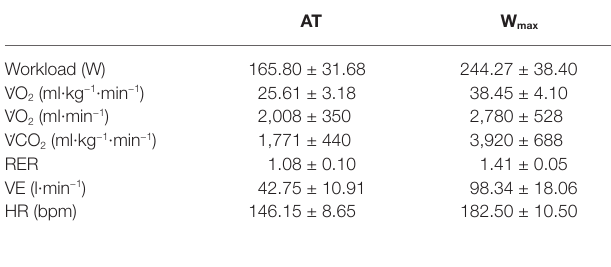
TABLE 1 | Mean values ± SD of metabolic data at the anaerobic threshold (AT) and at maximum workload (W max ) collected during the cardiopulmonary test. V ̇ O 2 , oxygen uptake expressed indexed for body mass (second line) as well as in absolute values (third line); V ̇ CO 2 , carbon dioxide production; RER, respiratory exchange ratio; VE, pulmonary ventilation; HR, heart rate. N = 12.